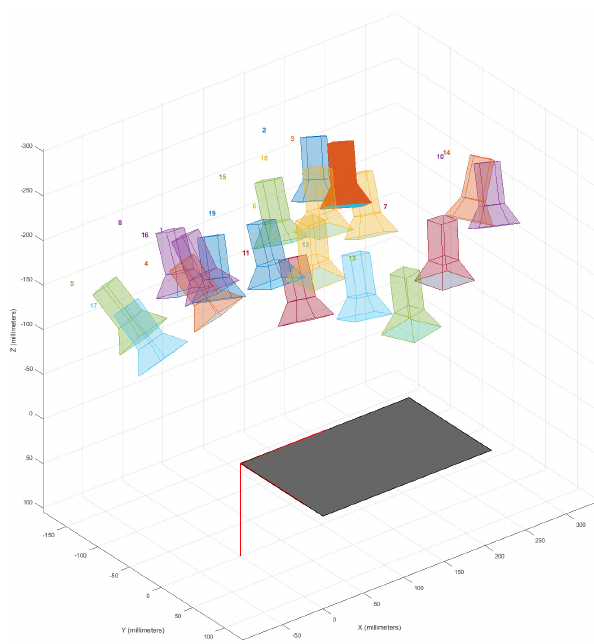
Figure 4. Illustration using Matlab’s Camera calibration application of the camera positions used when taking the calibration